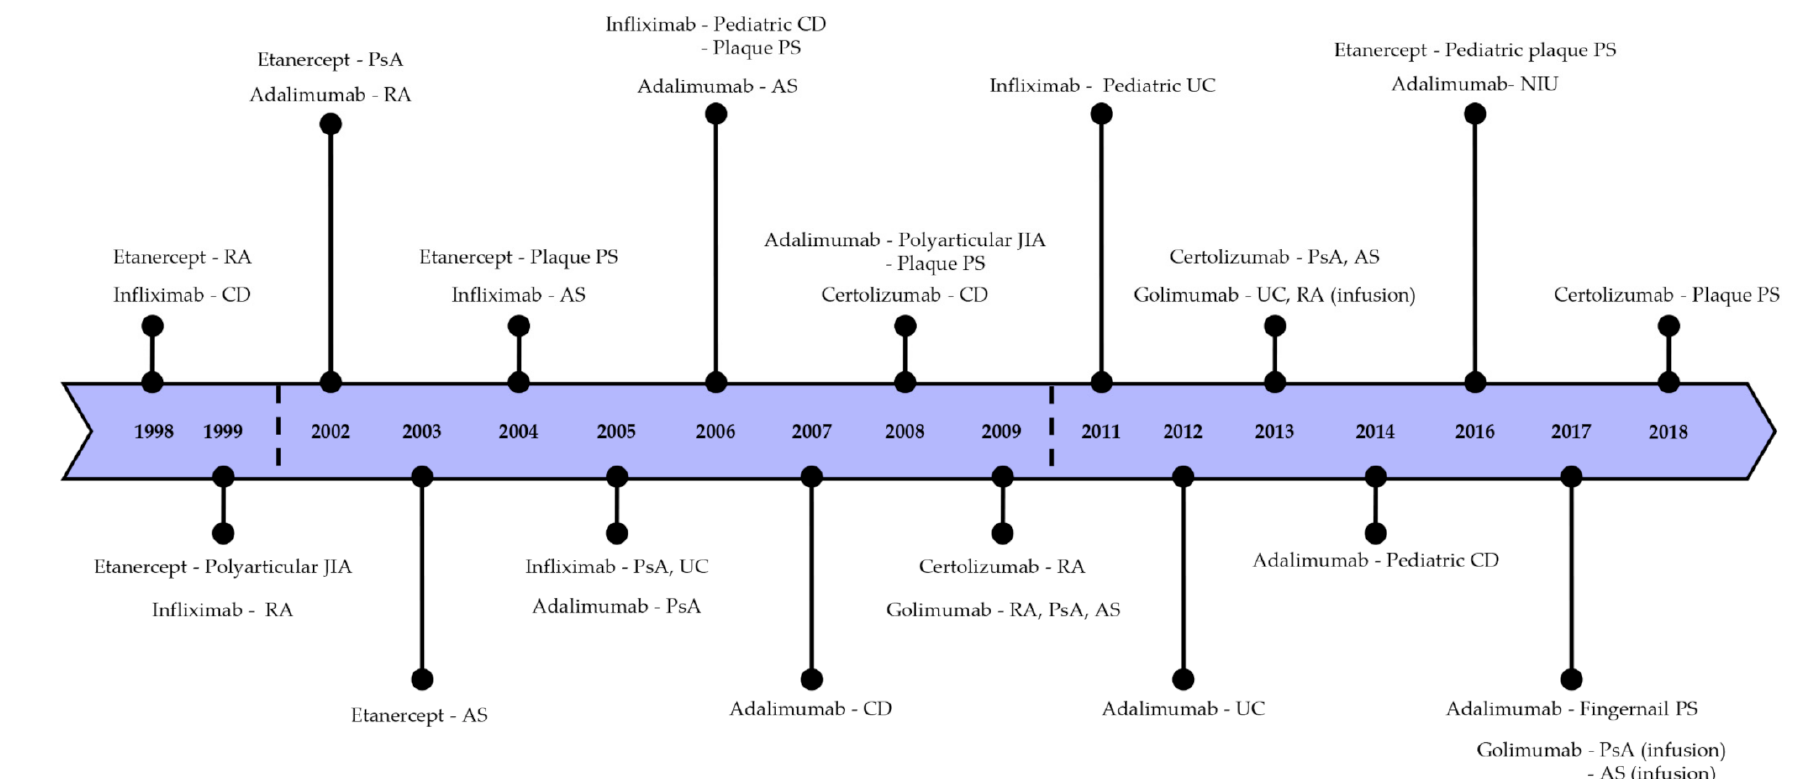
Figure 6. Timeline of the approval dates of TNF- α inhibitors in autoimmune